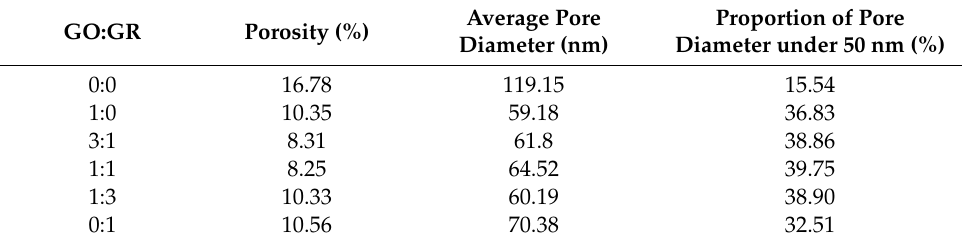
Figure 7. Pore size distribution of mortars with varied GO / GR hybrid at the age of 28 days. Table 5. Pore size distribution of mortars with GO/GR hybrid.